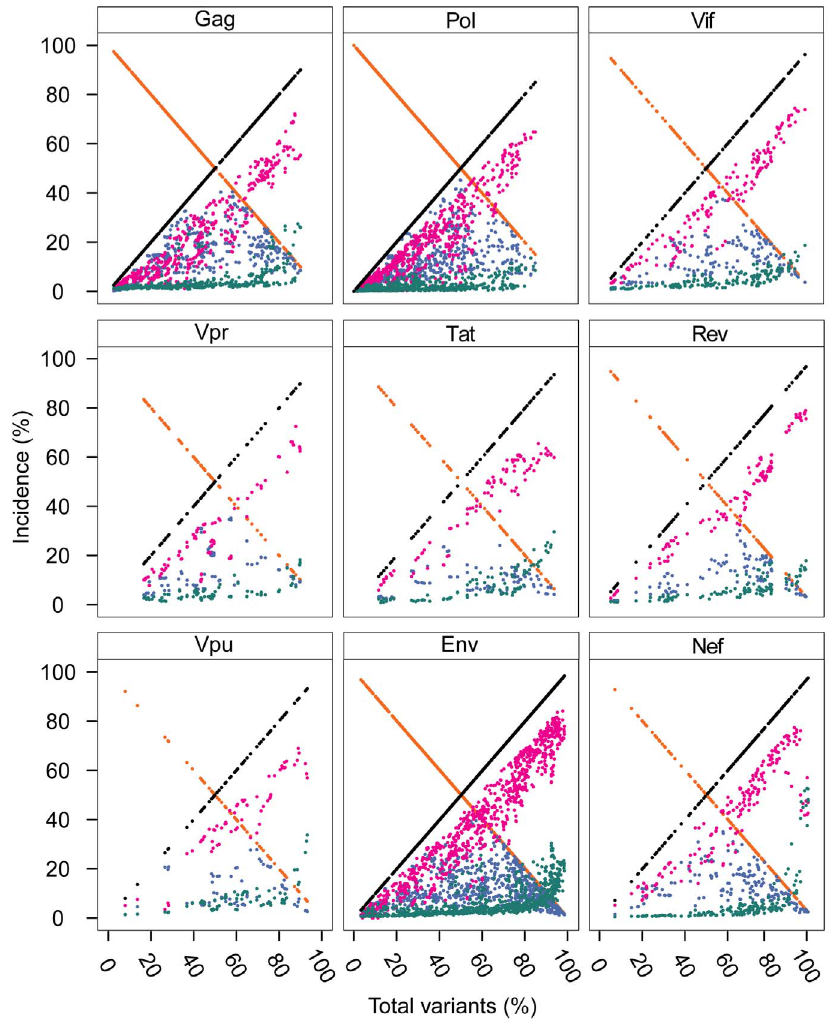
Figure 5. Dynamics of diversity motifs of HIV-1 clade B proteins. The color key for each sequence motif is described in Figure 4.